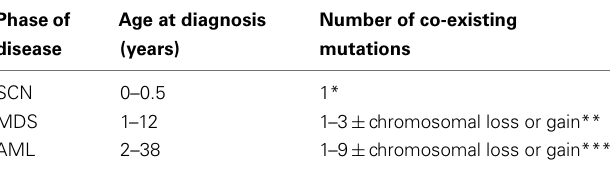
Table 1 | Summary of life histories of patients transitioning from severe congenital neutropenia (SCN) to secondary myelodysplastic syndrome (sMDS) to secondary acute myeloid leukemia (sAML) (Walter et al.,